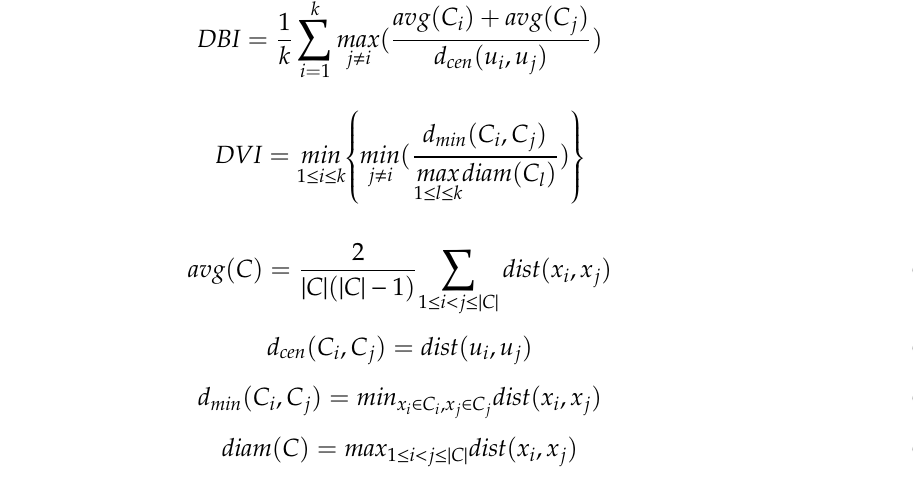
Figure 5. The results of experiments to compare clustering methods: ( a ) K-means; ( b ) K-medoids; ( c )